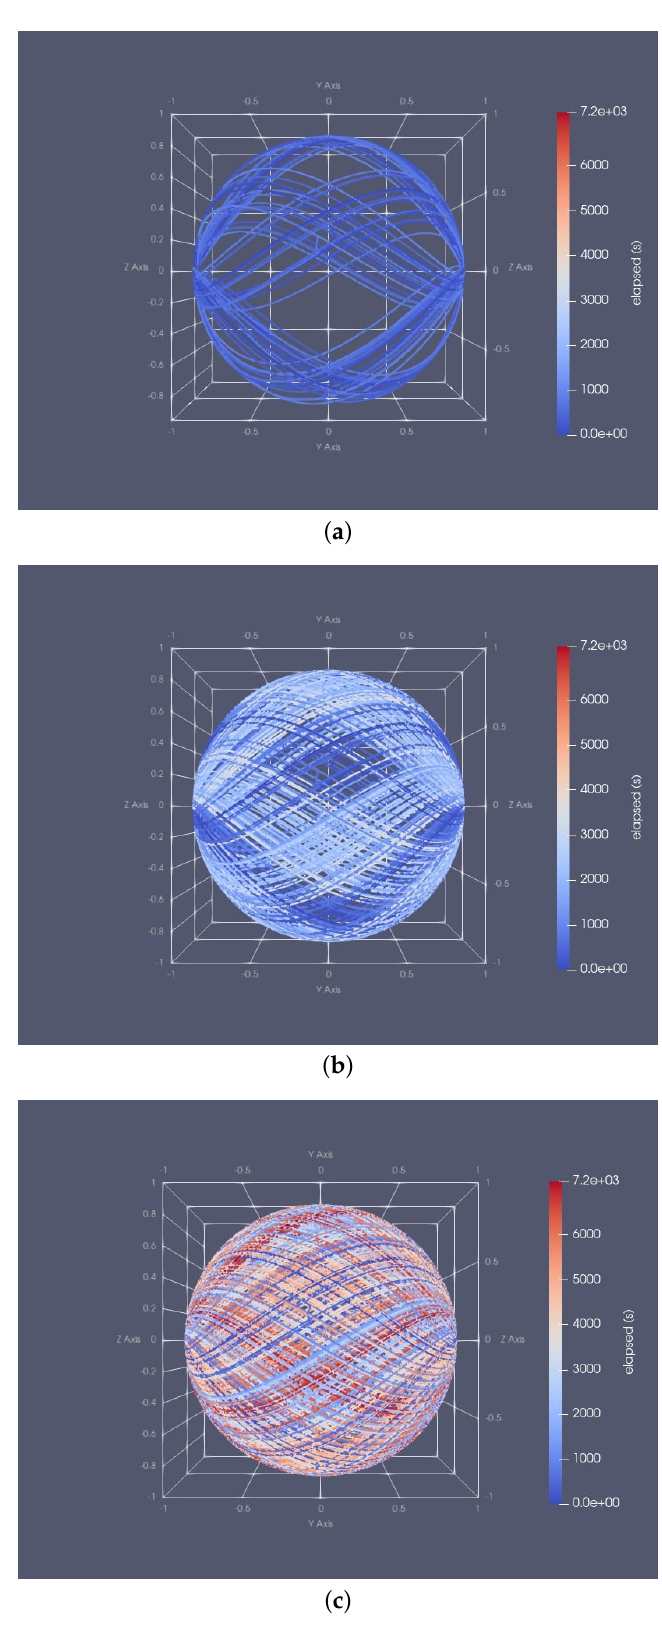
Figure A2. Motion trajectory of the gravity vector tip at a distances of 3.5 cm from the center displayed on imaginary sphere (in 3D mode) for ( a ) 15 min of rotation; ( b ) 1 h of rotation; ( c ) 2 h of